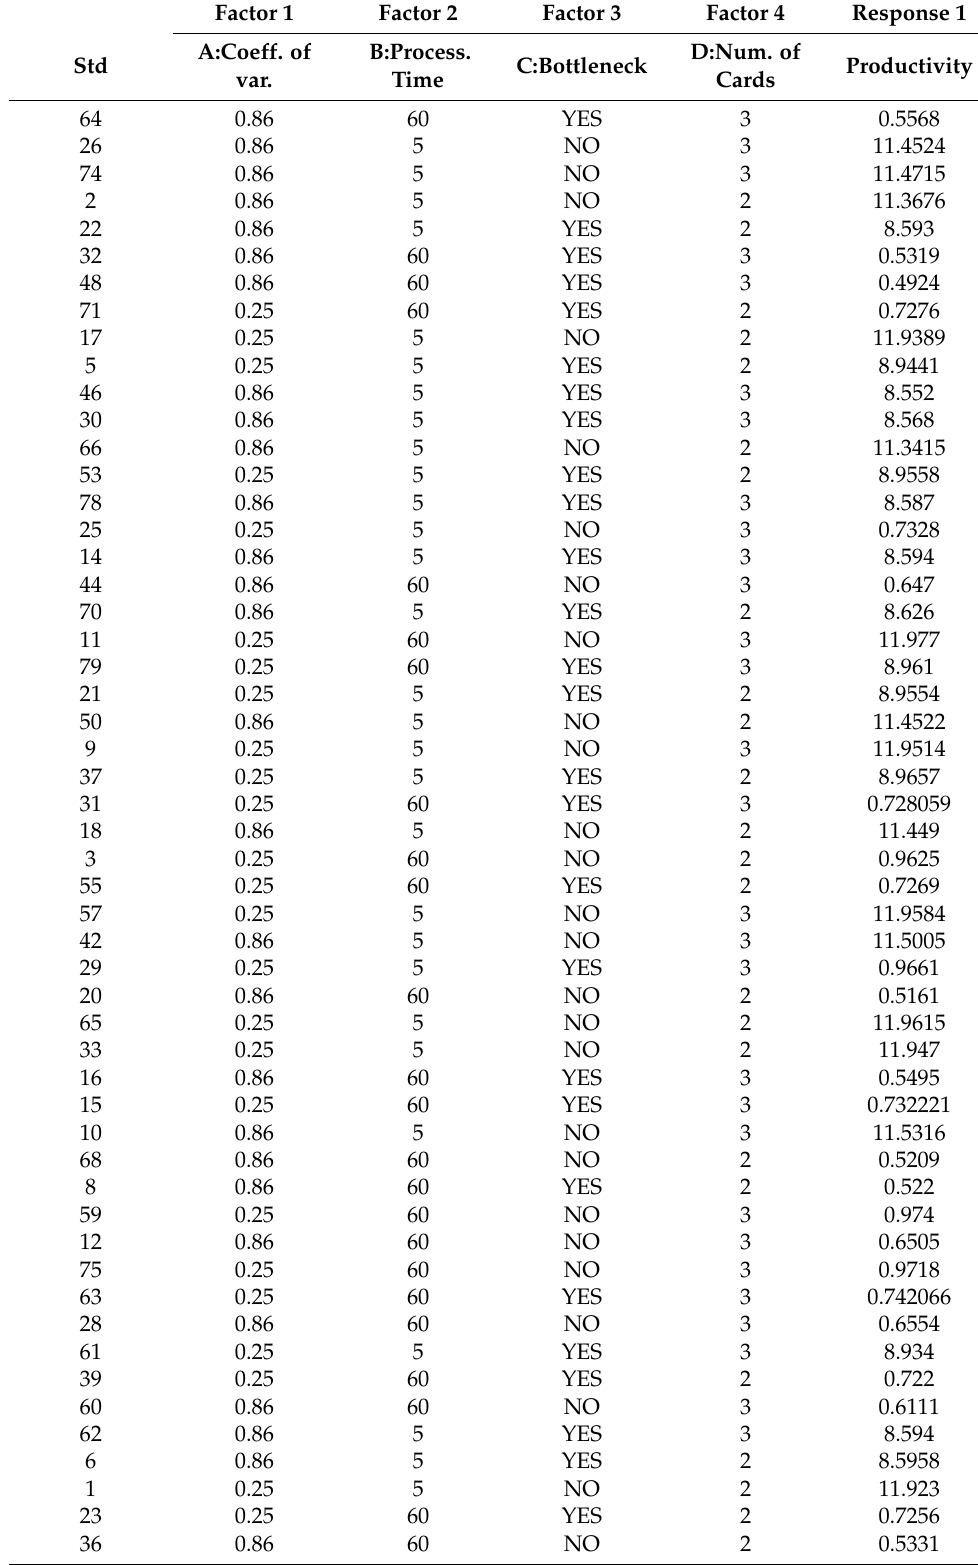
Table A3. Experiment design table—Hybrid